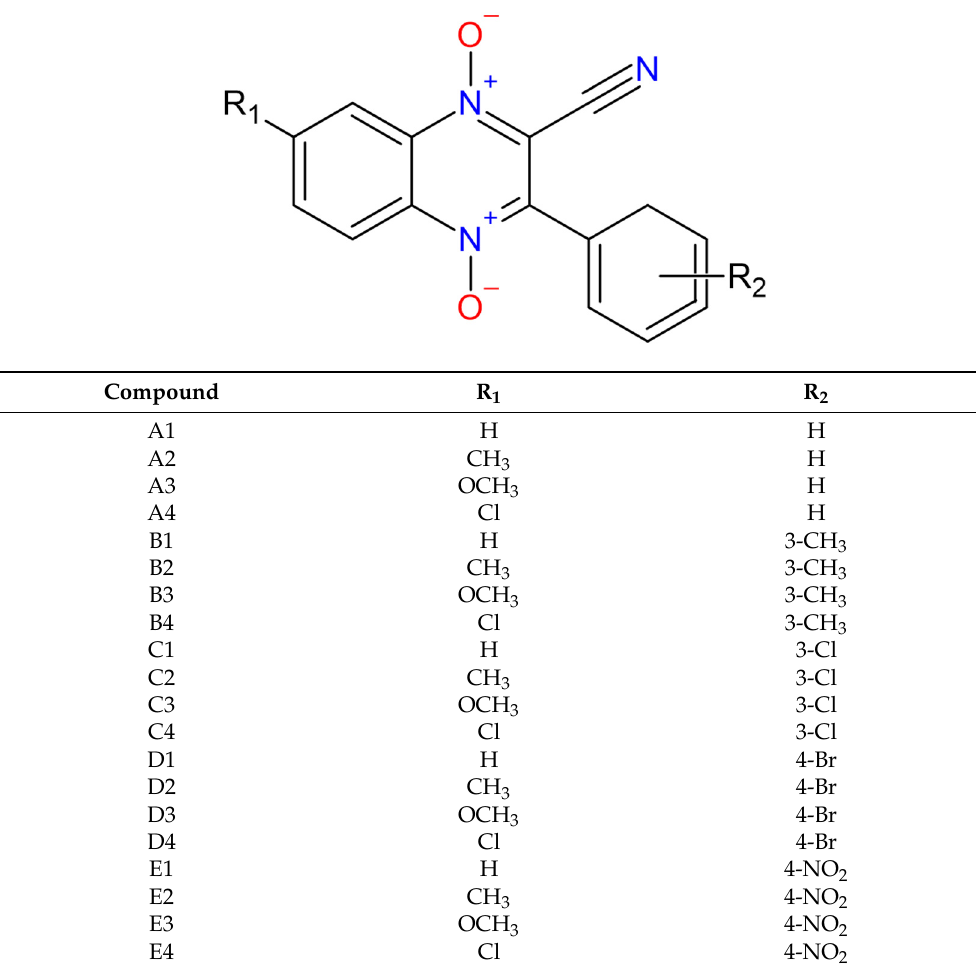
Table 1. The structure of the parent 3-aryl-quinoxaline-2-carbonitrile 1,4-di-N-oxide molecule drawn in ChemSketch [19] with the R1 and R2 substituents for each derivative indicated [27,28].